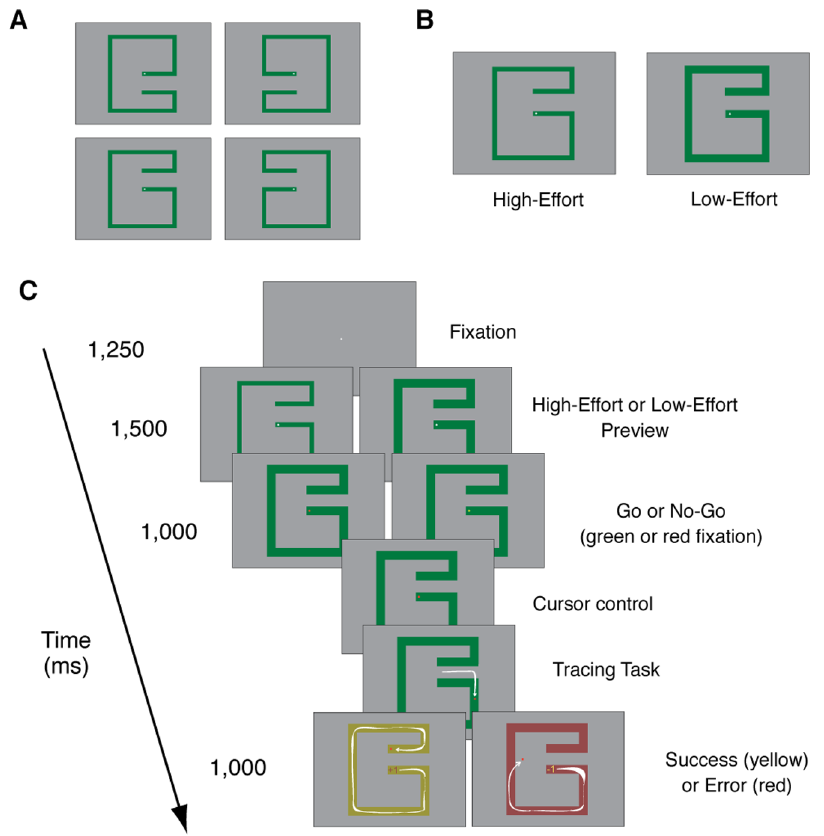
Figure 1. Stimuli and Task. (A) The four different spatial configurations for the maze. (B) Examples of Low-Effort and High-Effort mazes. (C) Schematic representation of the events on each trial. The trial started with a white central fixation presented for 1,250 ms. Following, one of the eight possible mazes was added to the fixation display. The presentation of the maze provided participants with a perceptual cue about how much effort the task was going to require. The fixation cross then changed color to red or light green to indicate a No-Go or Go trial, respectively. On Go trials, the fixation cross was replaced by a square cursor after 1,000 ms and the participants gained cursor control. Upon successful completion of the task, the maze turned yellow. In case of errors or time-outs the maze turned red.